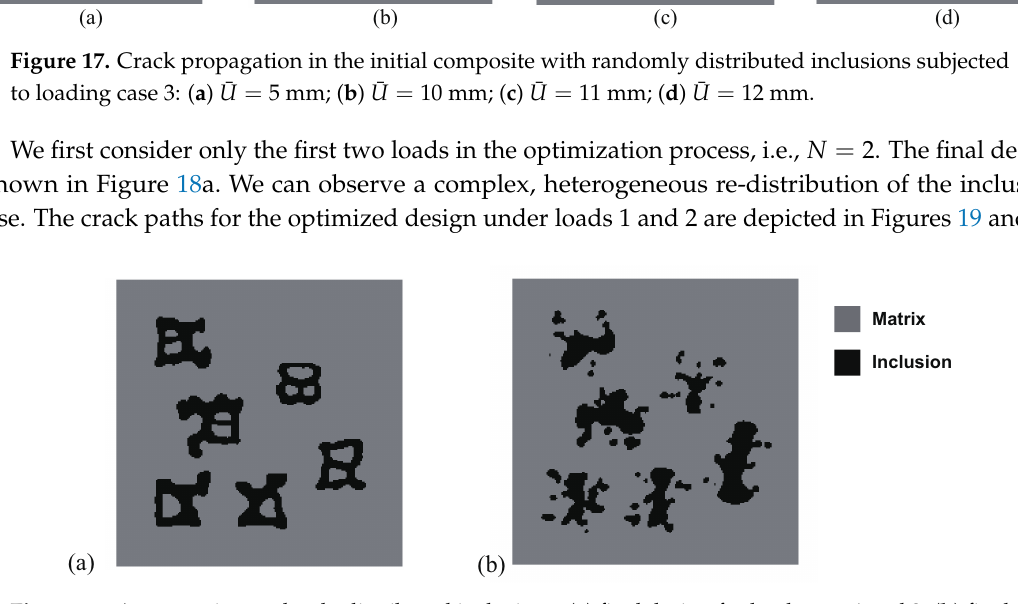
Figure 18. A composite randomly distributed inclusions: ( a ) final design for load cases 1 and 2; ( b ) final design for load cases 1, 2, and